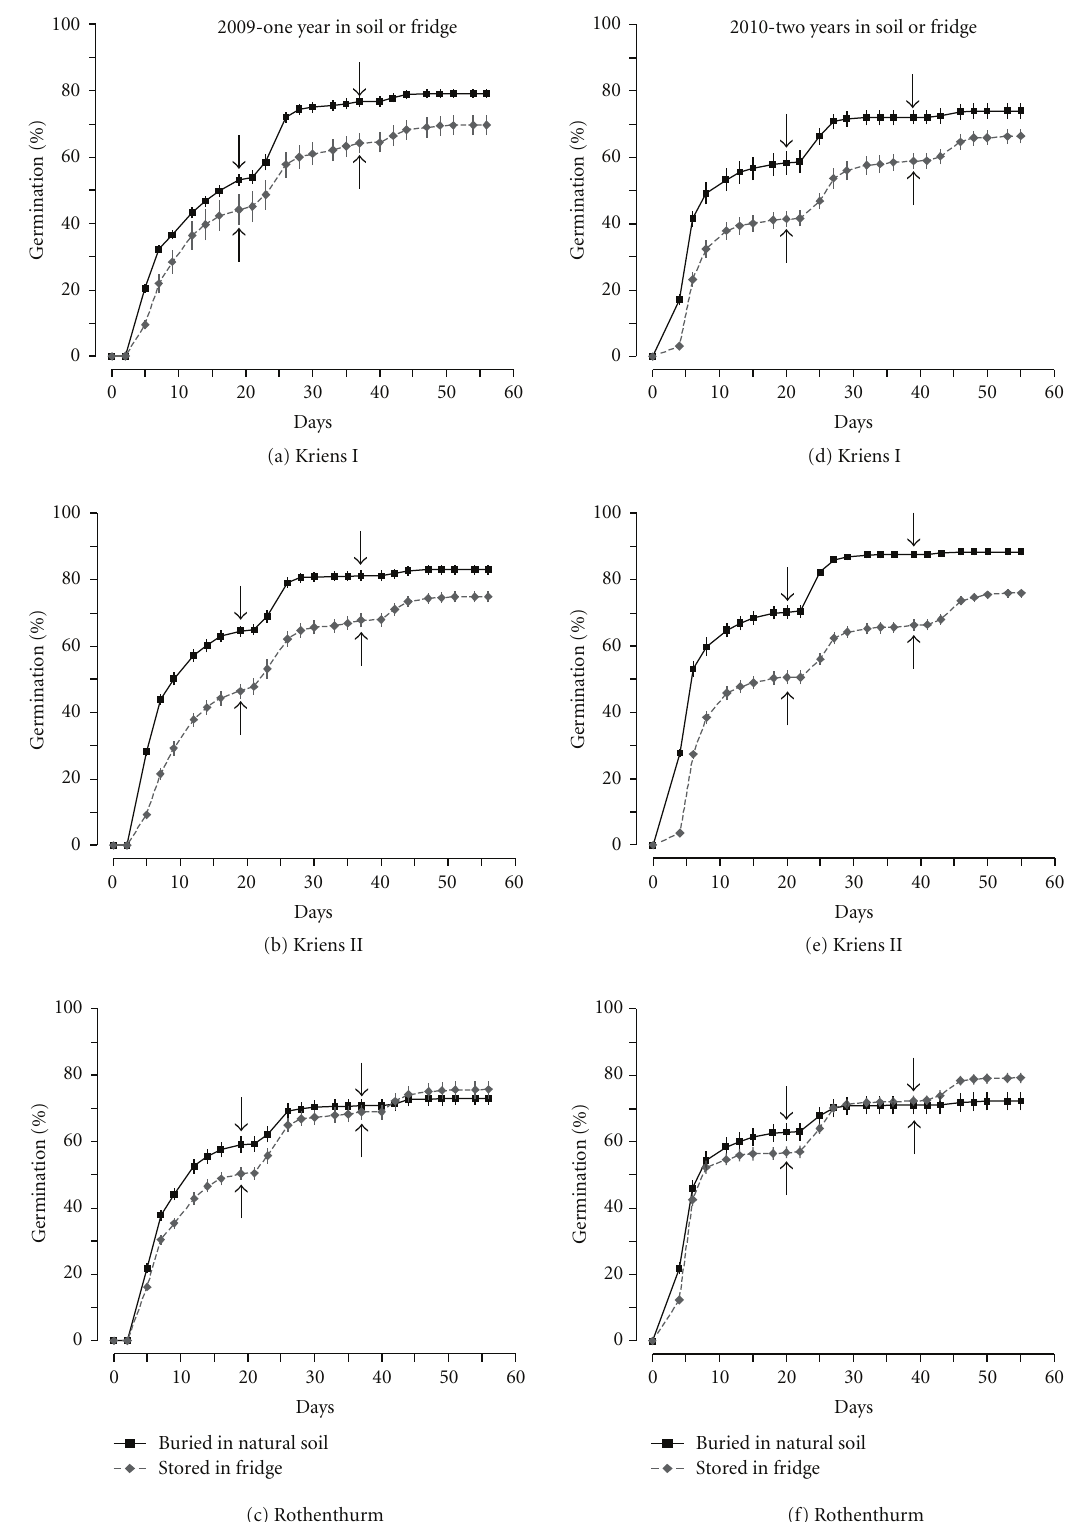
Figure 4: Germination percentages of seeds of Senecio aquaticus stored in the fridge and buried in natural soil; displayed are means ± SE ( n = 10). For germination, seeds were mixed with substrate that was spread in 5 mm thick layers. At noted dates ( ↓ , ↑ ) substrate was thoroughly crumbled to provide light to all